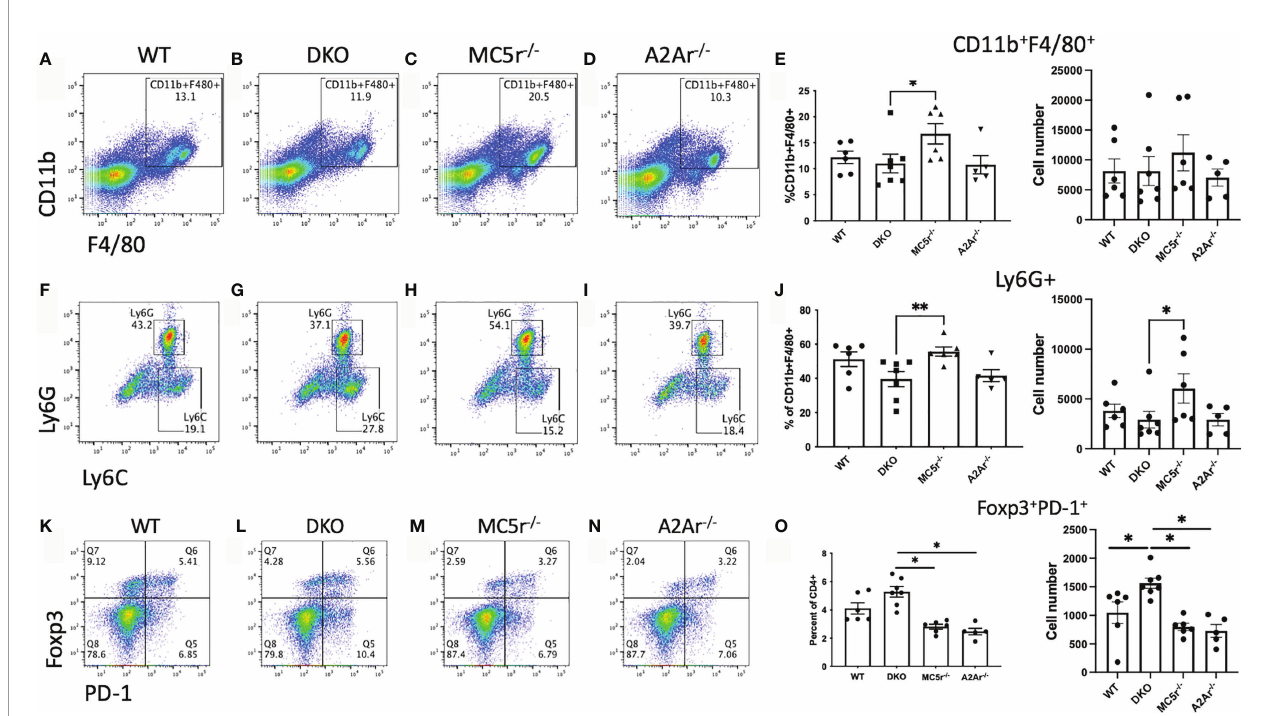
FIGURE 4 | Comparison of APC and Tregs at the onset of EAU in DKO with WT, MC5r -/- , and A2Ar -/- mice. Spleens from EAU onset (day 24) WT (n=6), DKO (n=7), MC5r -/- (n= 6), and A2Ar -/- (n= 5) were collected and stained for CD11b, F4/80, Ly6G, Ly6C, CD4, PD-1, and Foxp3. Representative pseudocolor dot plots and the mean ± SEM for each mouse are shown for CD11b and F4/80 (A – E) , Ly6G and Ly6C (F – J) , and PD-1 and Foxp3 (K – O) . The Ly-6G and Ly6C panels are gated on CD11b+F4/80+ cells, and PD-1 and Foxp3 panels are gated on CD4+ cells. Each experiment consisted of 1-2 mice, and each experiment was repeated 2-3 times. Signi fi cance was assessed by nonparametric Mann-Whitney U test. Statistical signi fi cance (*P ≤ 0.05 or **P ≤ 0.01) is designated by * and